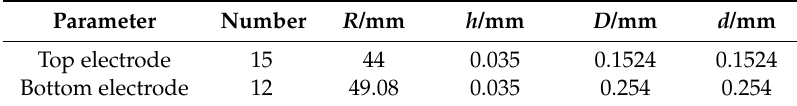
Table 1. Main structural parameters of the D-dot electric field sensor.